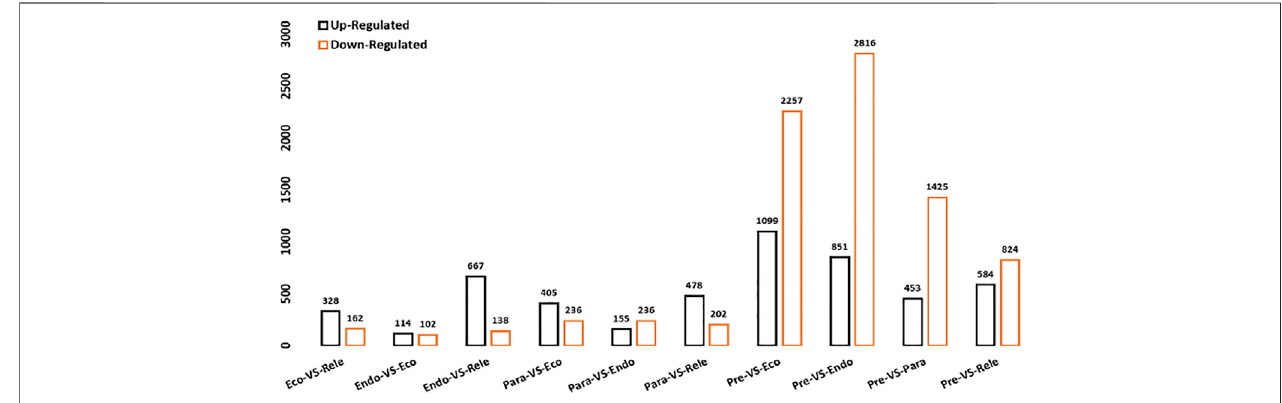
FIGURE 6 | Summary of Differentially Expressed Genes (DEGs); X -axis displayed differential expression patterns in all possible pairwise comparisons of bud dormancy samples. The Y -axis represented the number of DEGs. Orange-colored: up-regulated DEGs; black color: down-regulated DEGs.